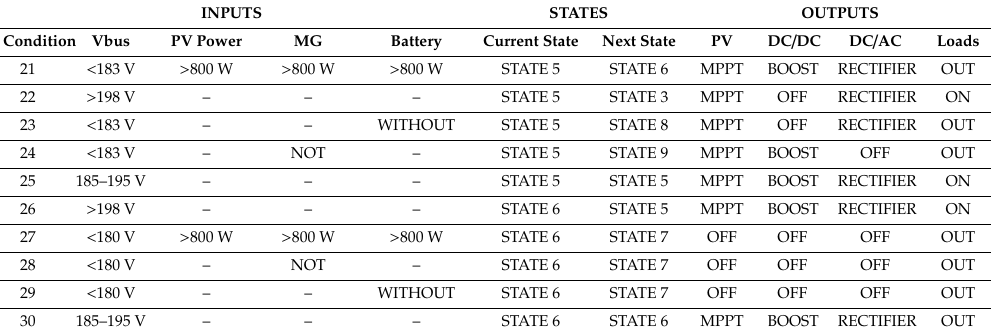
Table 6. GMC transitions in STATE 5 and 6.